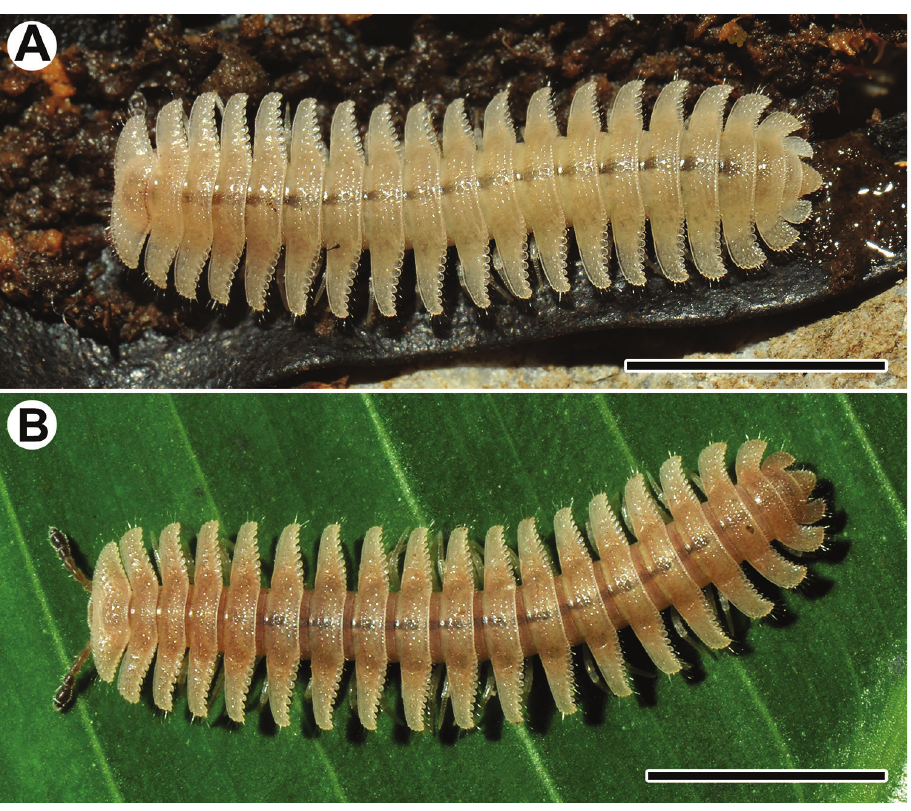
Figure 1. Habitus, live colouration of Trichopeltis sutchariti sp. n., A ♀ paratype B ♂ holotype . Scale bar: 5